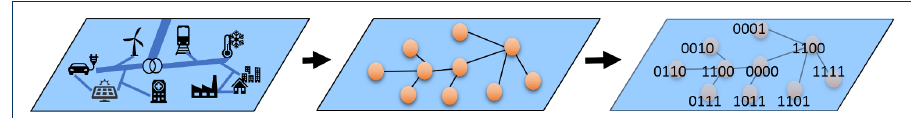
Figure 1 Three layers representing di(cid:11)erent abstractions of the grid topology in a distribution